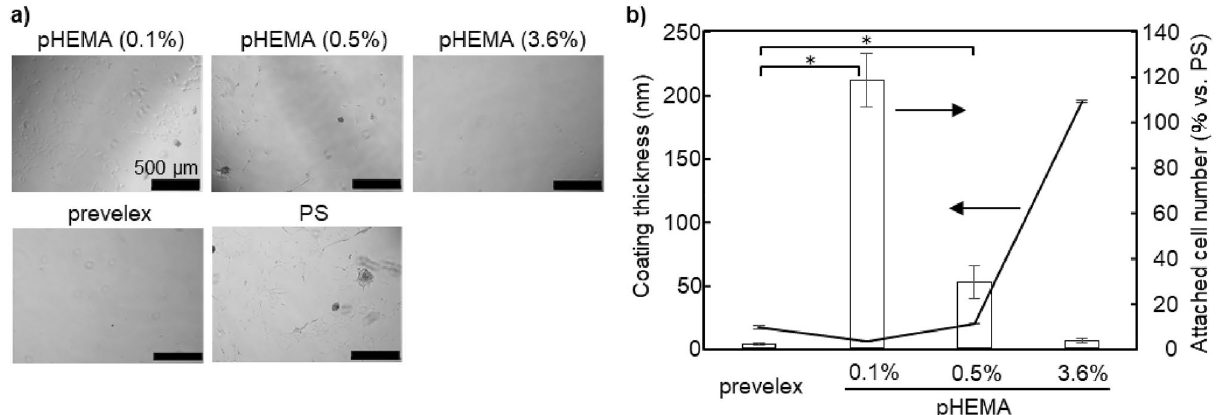
Figure 3. Cell repellent of prevelex-coated surfaces. ( a ) Phase-contrast microscopic images of culture surface 4 days after cell seeding. PS substrates are coated with the different coating agents. ( b ) Coating thickness and attached cell number. Thickness of coating layer was quantified with spectroscopic ellipsometry. Number of attached cells are quantified by measuring the amount of adenosine triphosphate. Error bars represent standard error calculated from three independent measurements. Numerical variables are statistically evaluated using ANOVA, and *p < 0.05 is considered statistically